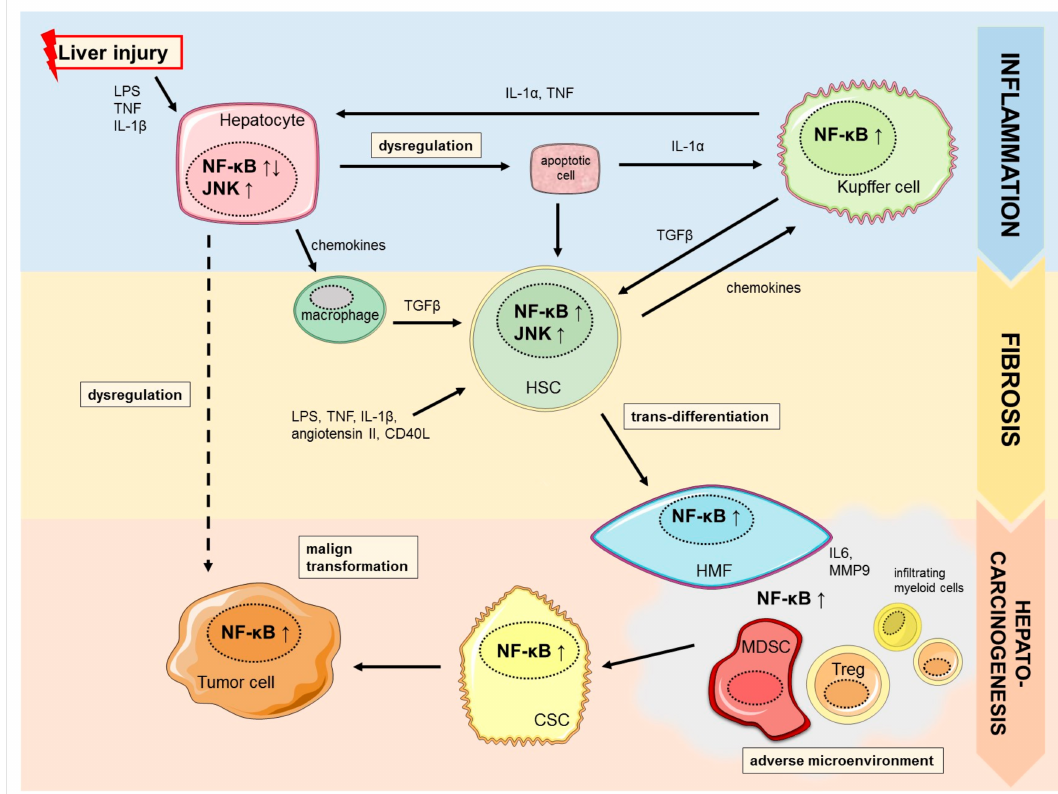
Figure 1. Context-dependent role of NF- κ B signaling. NF- κ B is involved in inflammation-fibrosis-cancer axis in a cell type dependent manner. Activated NF- κ B and JNK signaling possess anti-apoptotic